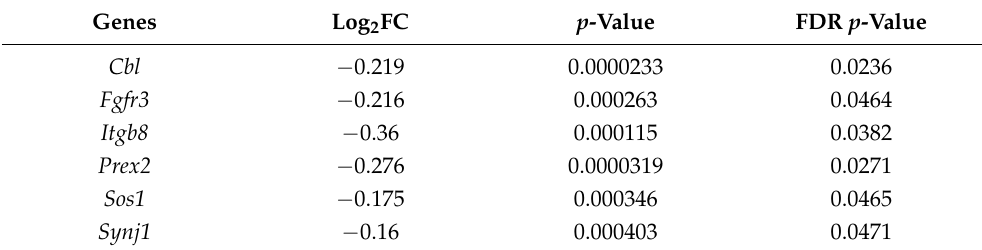
Table 2. PTEN signaling-related genes in Homo PKC γ -A24E.